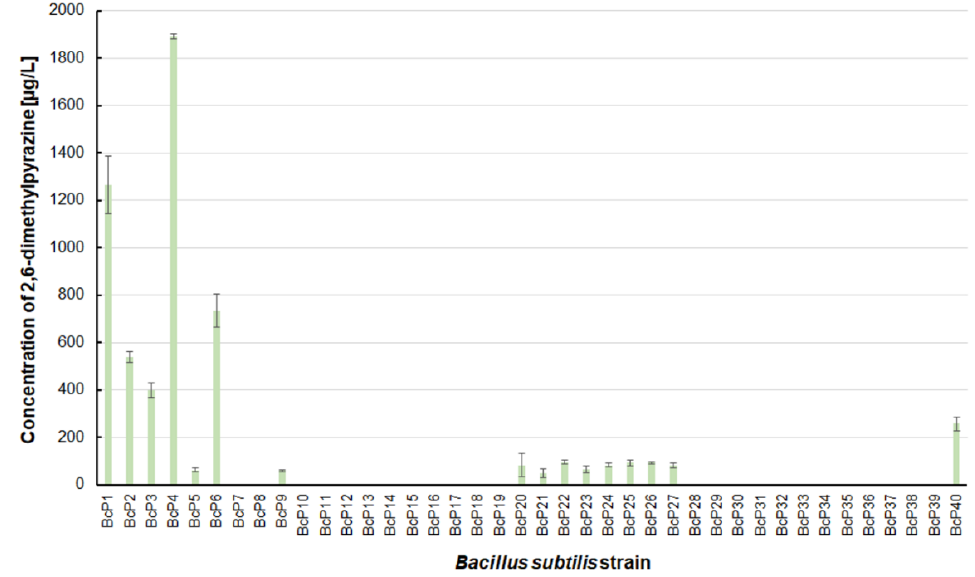
Figure 5. The 2,6-dimethylpyrazine biosynthesis by B. subtilis strains. Only two B. subtilis strains (BcP21 and BcP40) were able to produce 2,5-dimethylpyrazine at concentrations greater than 4.5 mg/L (Figure 6). The BcP40 strain produced this compound at the highest concentration of 5.665 ± 0.326 mg/L.